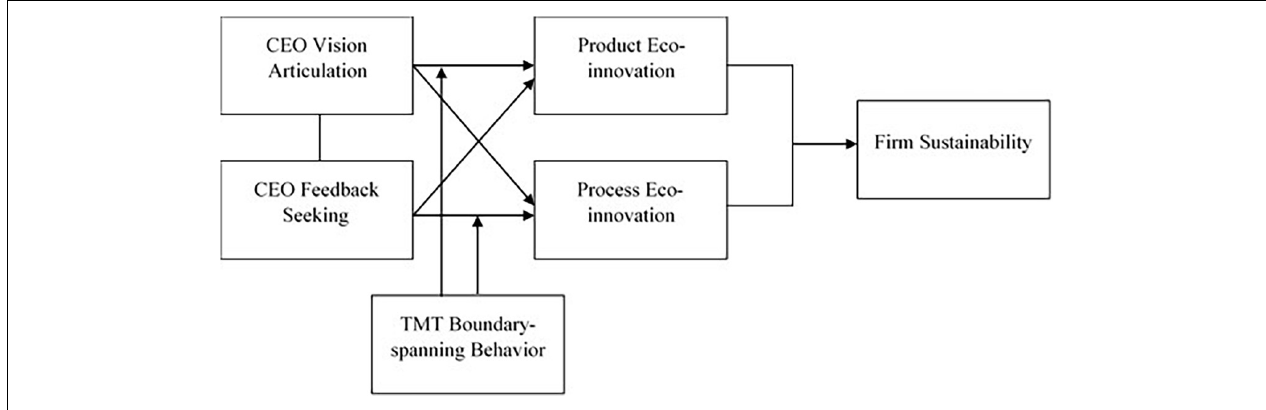
FIGURE 1 | The proposed moderated mediation